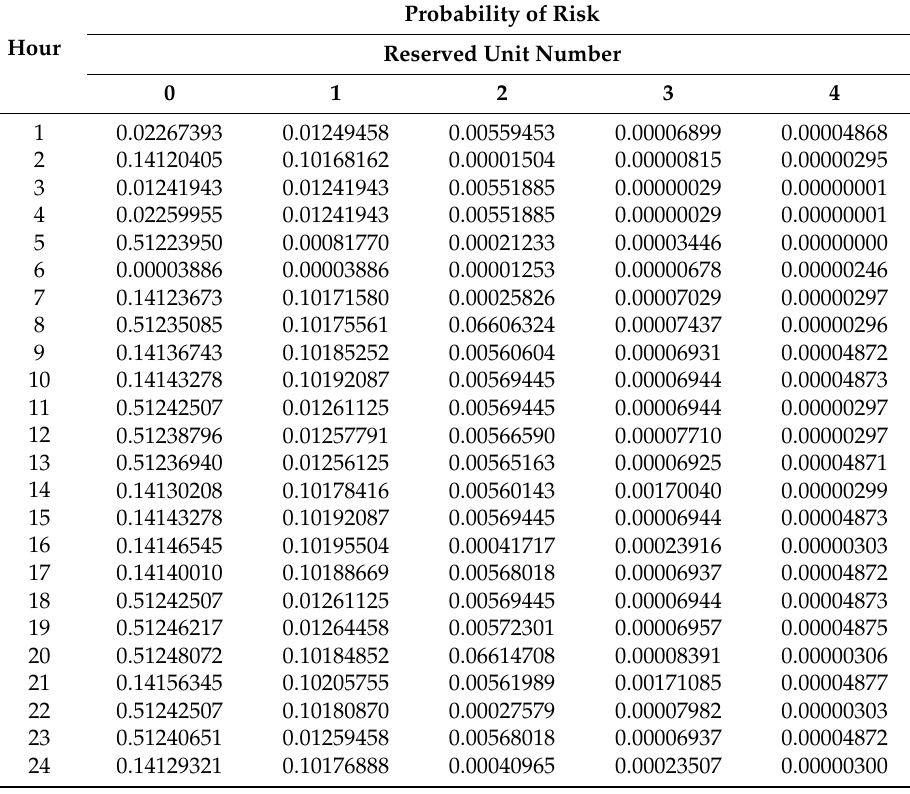
Table 3. Probabilities of risk under scenario (1) with a certain number of GT units set aside as